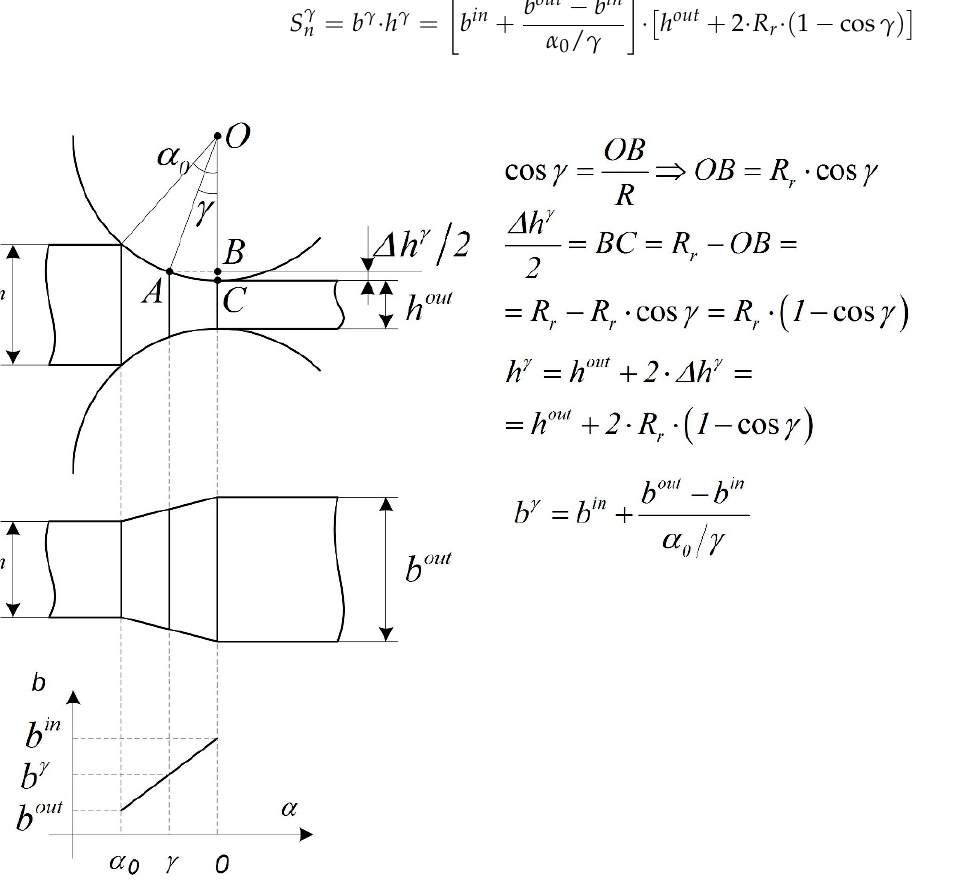
Figure 5. Determination of the critical surface area.